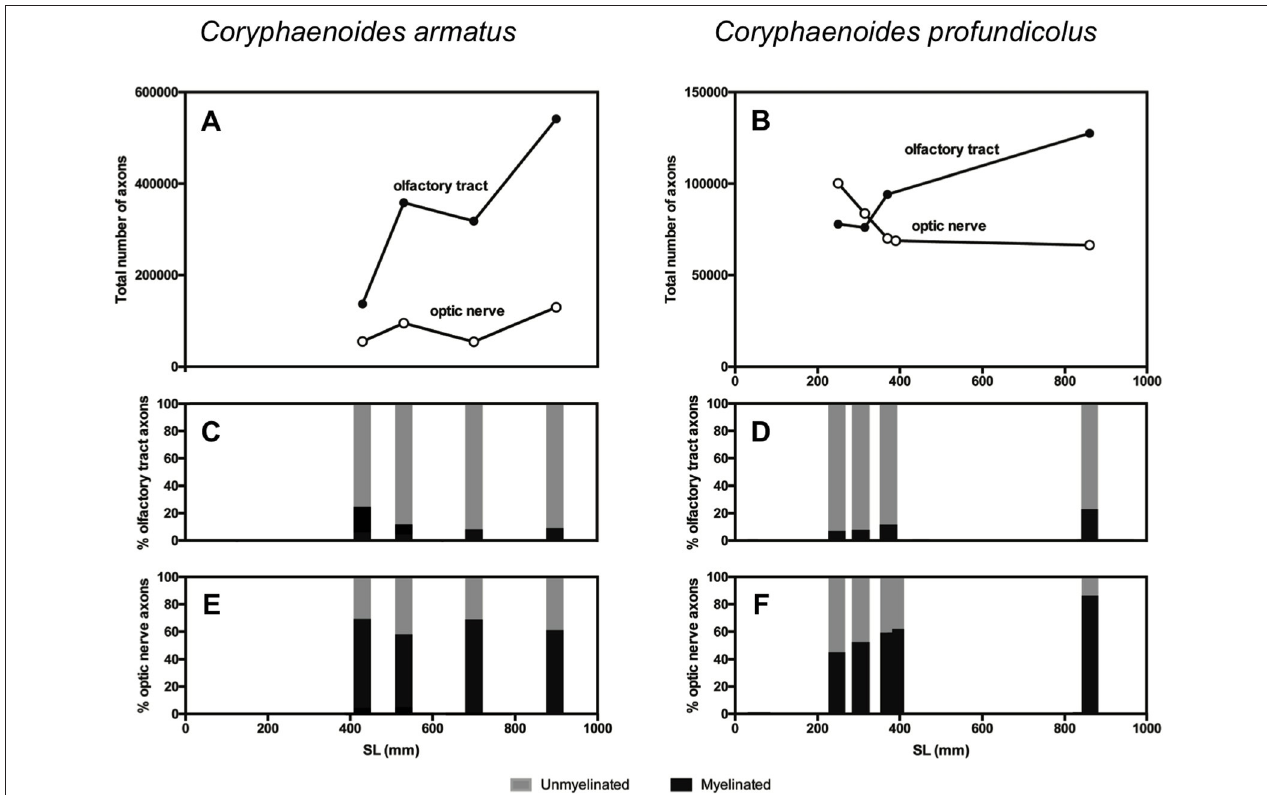
FIGURE 3 | Axons in the olfactory tract and the optic nerve in Coryphaenoides armatus and C. profundicolus . The total number of axons in the olfactory tract (filled circles) and optic nerve (open circles) from different sized individuals in the two species is presented for (A) C. armatus and (B) C. profundicolus . Ontogenetic variation in the percentage of myelinated (black) and unmyelinated (gray) axons in the olfactory tract (C) and optic nerve (E) from different-sized individual C. armatus , and in the olfactory tract (D) and optic nerve (F) from different-sized individual C. profundicolus